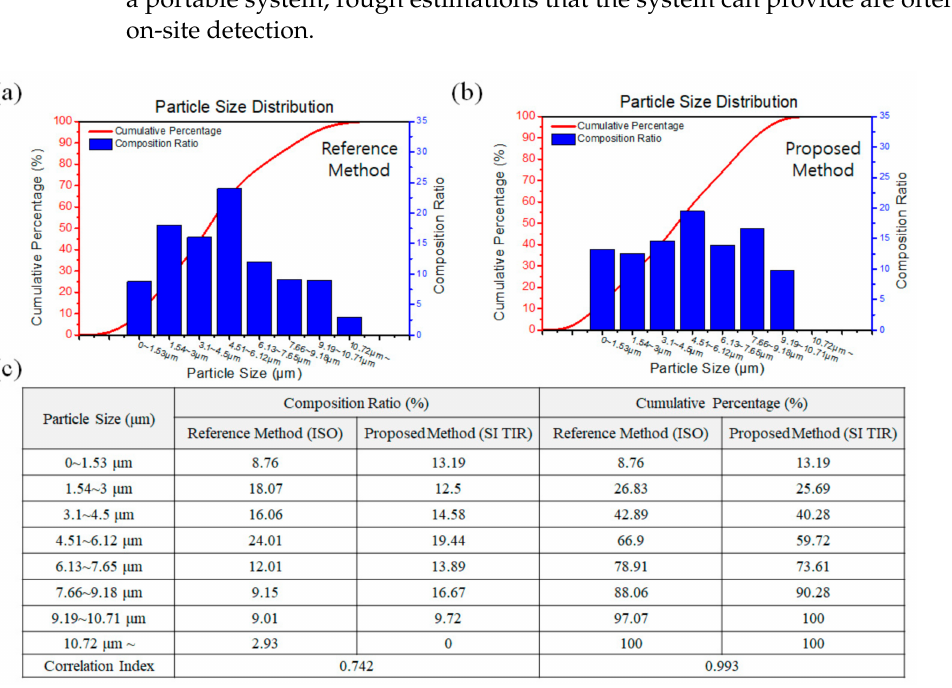
Figure 4. Analysis of particle size distribution using the ISO 12103-1 A1 ultrafine test dust. Actual particle size distribution of the tested sample from the datasheet ( a ) and data analyzed using the developed system ( b ). Correlation index between the reference and proposed method was calculated as 0.742 for the composition ratio and 0.993 for the cumulative percentage, respectively ( c